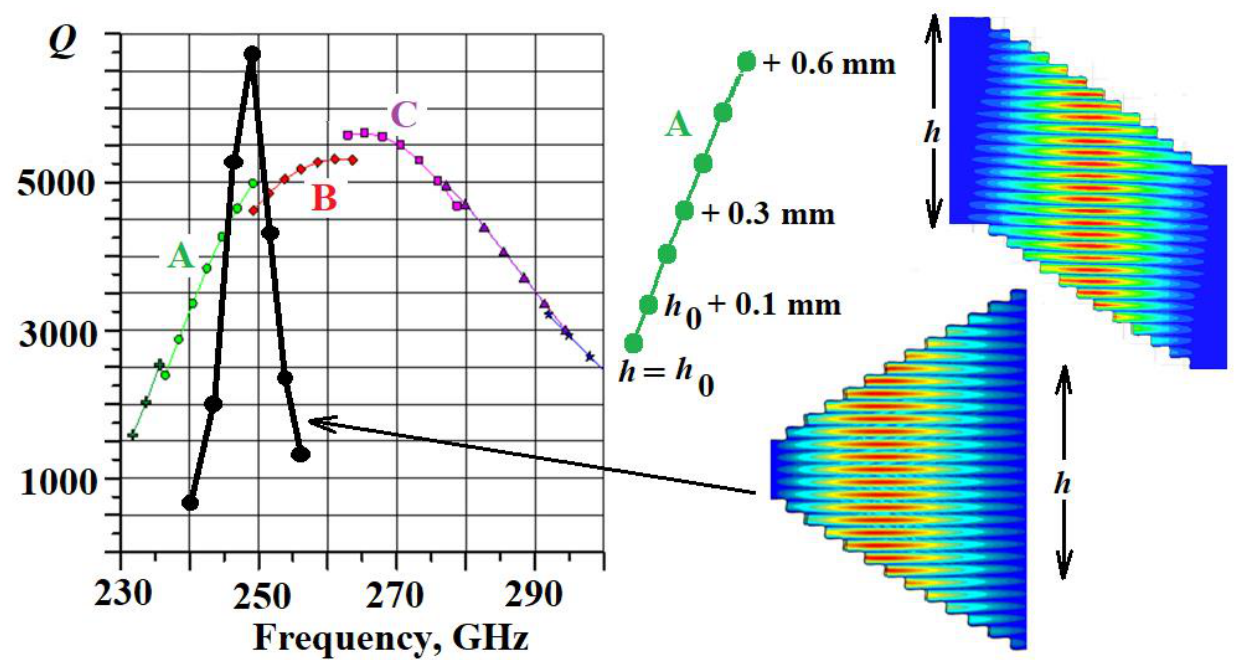
Figure 5. Mode Q-factor versus frequency. Different curves correspond to modes with different numbers of longitudinal field variations. Different points on the same curve correspond to different distances between the gratings h for the same mode with a fixed number of field variations. The distance between the gratings changes from h 0 = 10 mm up to h 0 + 0.6 mm with a step of 0.1 mm. Curves A, B, and C correspond to the modes A, B, and C in Figure 4. For comparison, the echelette cavity with the same gratings and the same average distance between the gratings has only one longitudinal mode, and its sharp dependence on the inter-grating distance is demonstrated with a black